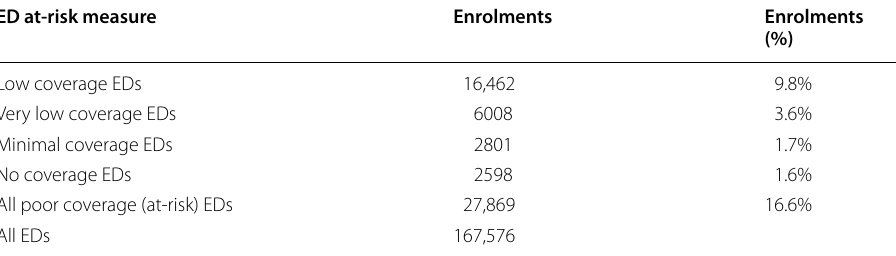
Table 1 Number and proportion of higher education student enrolments at risk of poor access to high speed